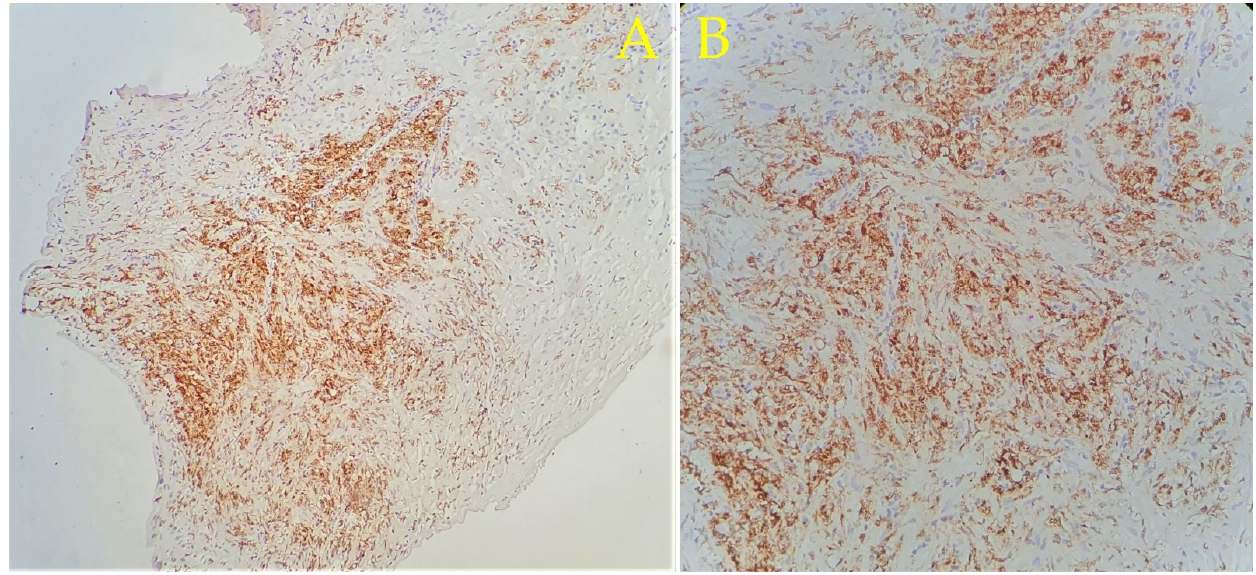
Figure 7. Immunohistochemical analysis using CD68 staining antibodies. ( A ) using 10× lens: the overall picture is of a highly metabolically active granulation tissue that is not yet matured. ( B ) using 20× lens: intense positivity and diffuse capture in the cytoplasm of the macrophages, identifying them as CD68+ foamy macrophages.